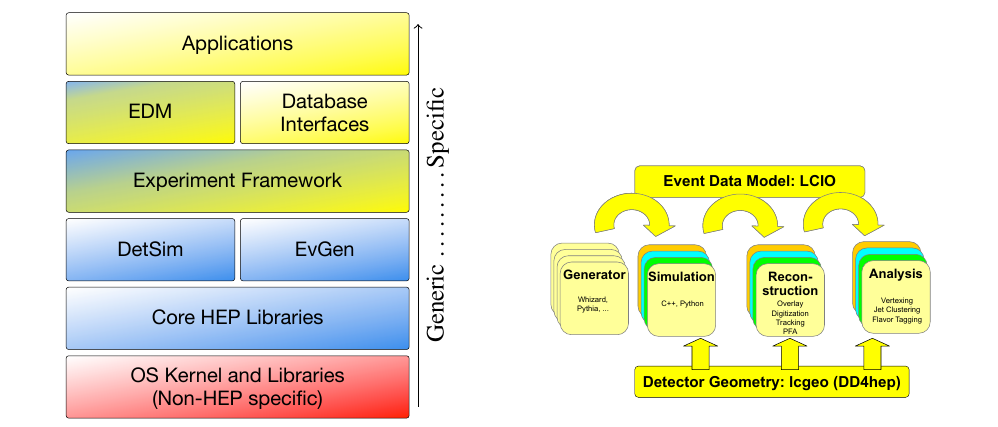
Figure 1. A stack of software libraries from generic to specific